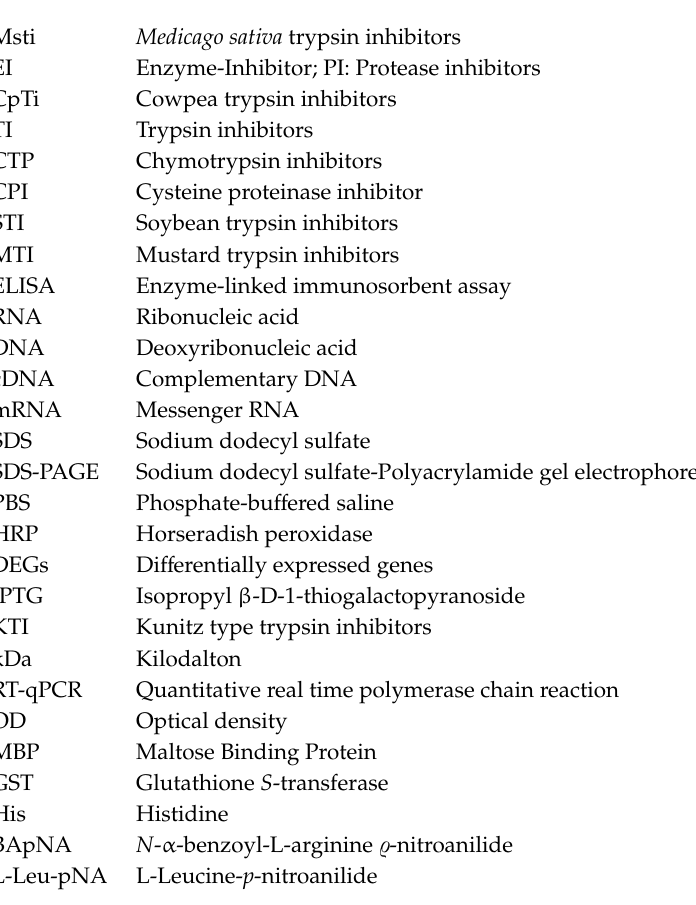
Figure S1: Step-wise process of spotted alfalfa aphids reared with an artificial diet. (A) Healthy active spotted alfalfa aphid; (B) Aphid’s artificial diet; (C) feeder with aphids sealed from the bottom with a sponge; (D) artificial diet poured on the first layer of Parafilm M ® ; (E) sealed with another layer of Parafilm M ® from the top; (F) aerial view of aphids feeding. Table S1: Equation of di ff erent enzyme curve along with regression value; Table S2: Enzyme activities assays of aphids on di ff erent concentration of feed with Msti-94 recombinant protein; Table S3: Enzyme activities assays of aphids on di ff erent concentration of feed with Msti-16 recombinant protein; Table S4: Enzyme activities assays of ahpids on di ff erent feed with recombinant purified